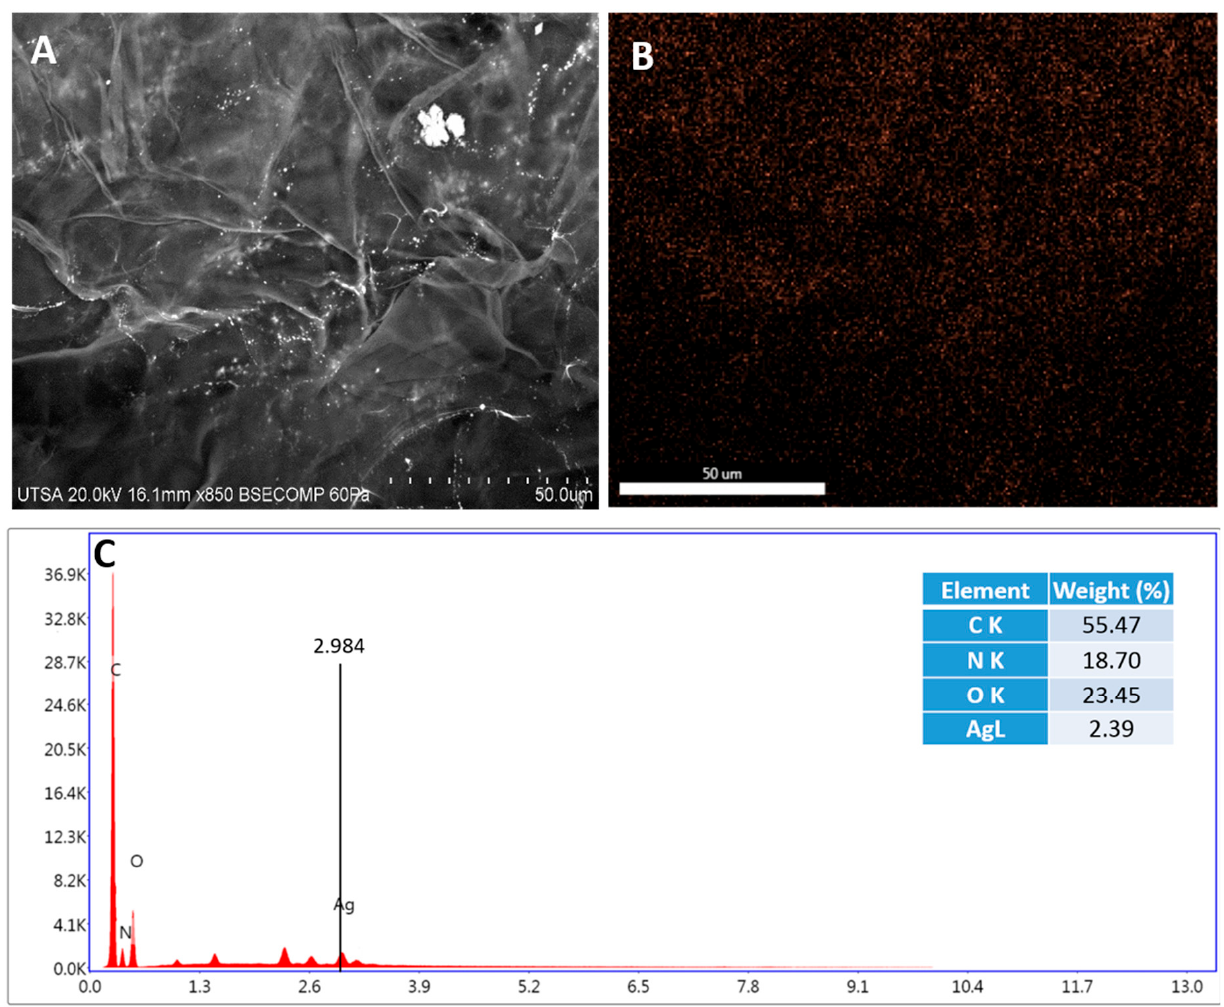
Figure 3. Radiosterilized porcine skin epidermis shows a homogeneous covering of silver nanopar- ticles. ( A ) SEM image of the epidermis; ( B ) EDS mapping of the epidermis, orange dots represent the distribution of Ag; and ( C ) analysis of elements expressed as the percentage of elements on the epidermis performed by EDS mapping.